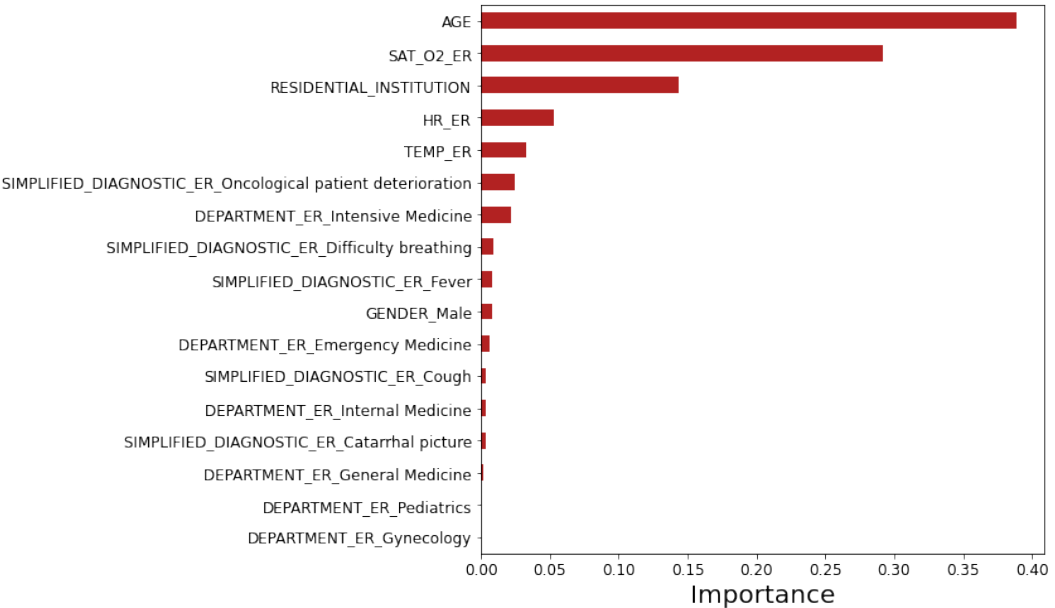
Figure 7. Importance of the variables according to the random forest